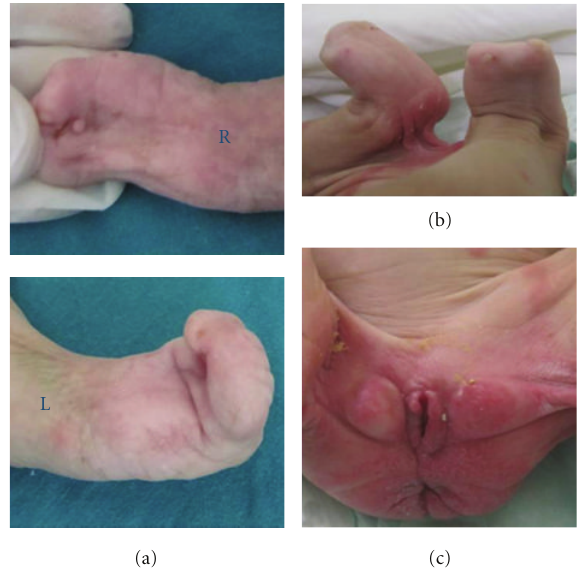
Figure 4: (a) Complete syndactyly (mitten hands), absent nails, left single transverse palmar crease and right tag (b) Adactyly of both feet with a single toenail in right foot (c) Ambiguous external genitalia. Note the stenotic anal orifice.